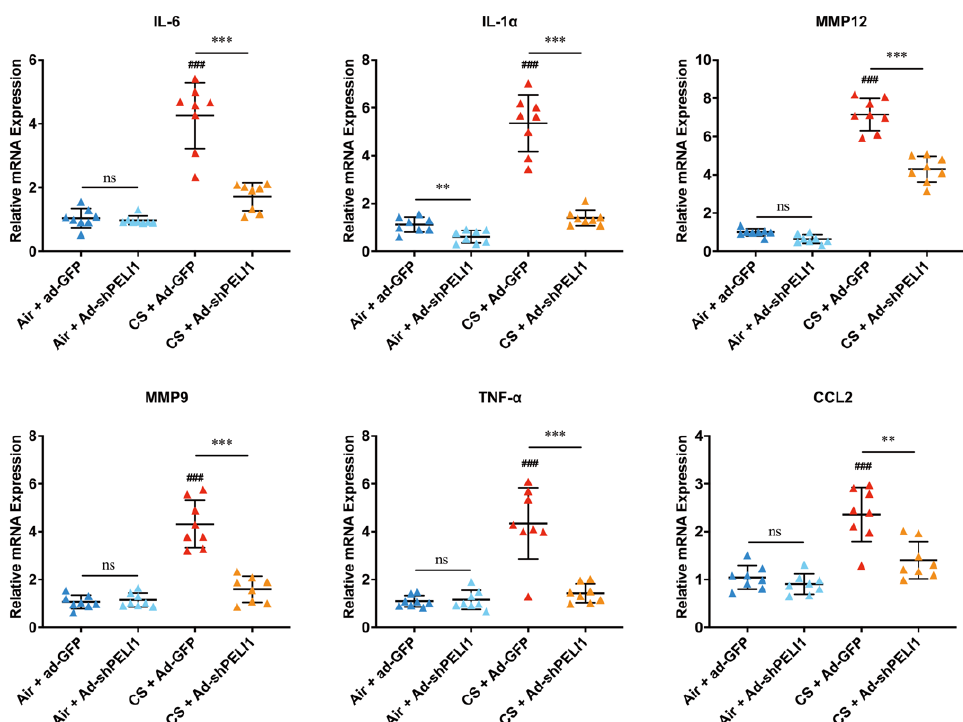
Figure 5. Silencing PELI1 decreased the high mRNA expression of SASPs caused by CS. ASPs including IL-6, IL-1 α , MMP-9, MMP-12, TNF α , and CCL2 were significantly increased in the CS group, which could be decreased by silencing PELI1. Data represent mean ± SEM; ### p < 0.001 vs. (Air + Ad-GFP group), ** p < 0.01, *** p < 0.001 vs. (CS + Ad-GFP group), ns for not significant, n = 8 mice.